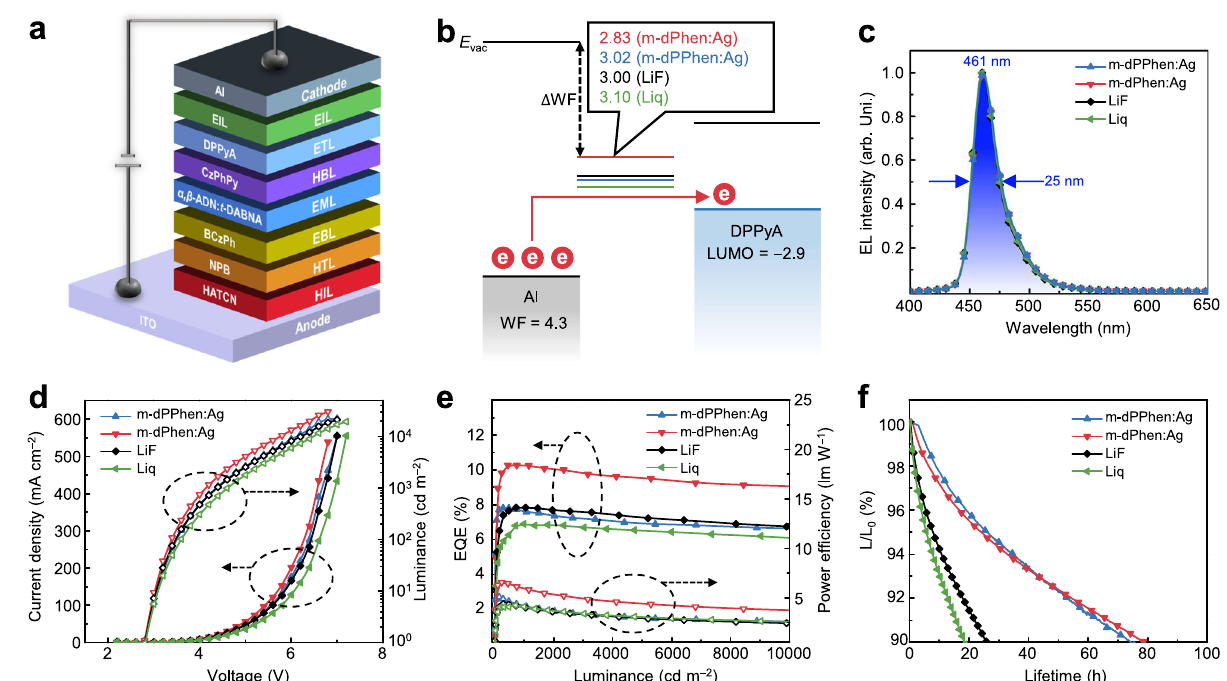
Fig. 5 Summary of deep-blue OLEDs based on different EILs. a The device structure of deep-blue OLEDs. b Energy level alignment of the EILs of LiF (1 nm), Liq (1 nm), m-dPPhen:Ag (5nm, 10 wt%), and m-dPhen (5 nm, 10wt%)/DPPyA in devices. c The EL spectra under 1000cd m − 2 . d The current density − voltage − luminance ( J − V − L ) of the OLEDs using different EILs of LiF (1 nm), Liq (1nm), m-dPPhen:Ag (5 nm, 10wt%), and m-dPhen (5 nm, 10wt%) for comparison. e EQE − power ef fi ciency − luminance of the OLEDs using different EILs. f The lifetimes measured at an initial luminance of 2000 cd m − 2